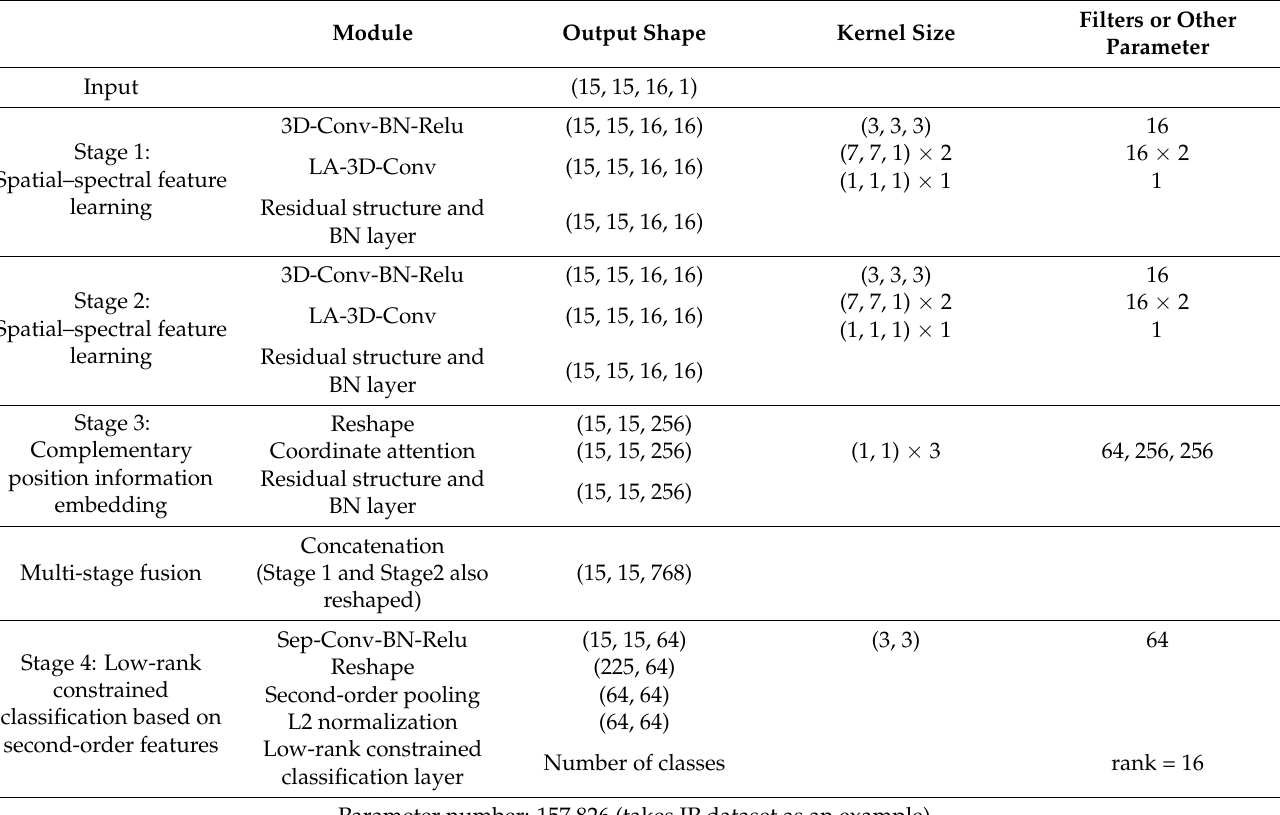
Table 1. The implementation details of